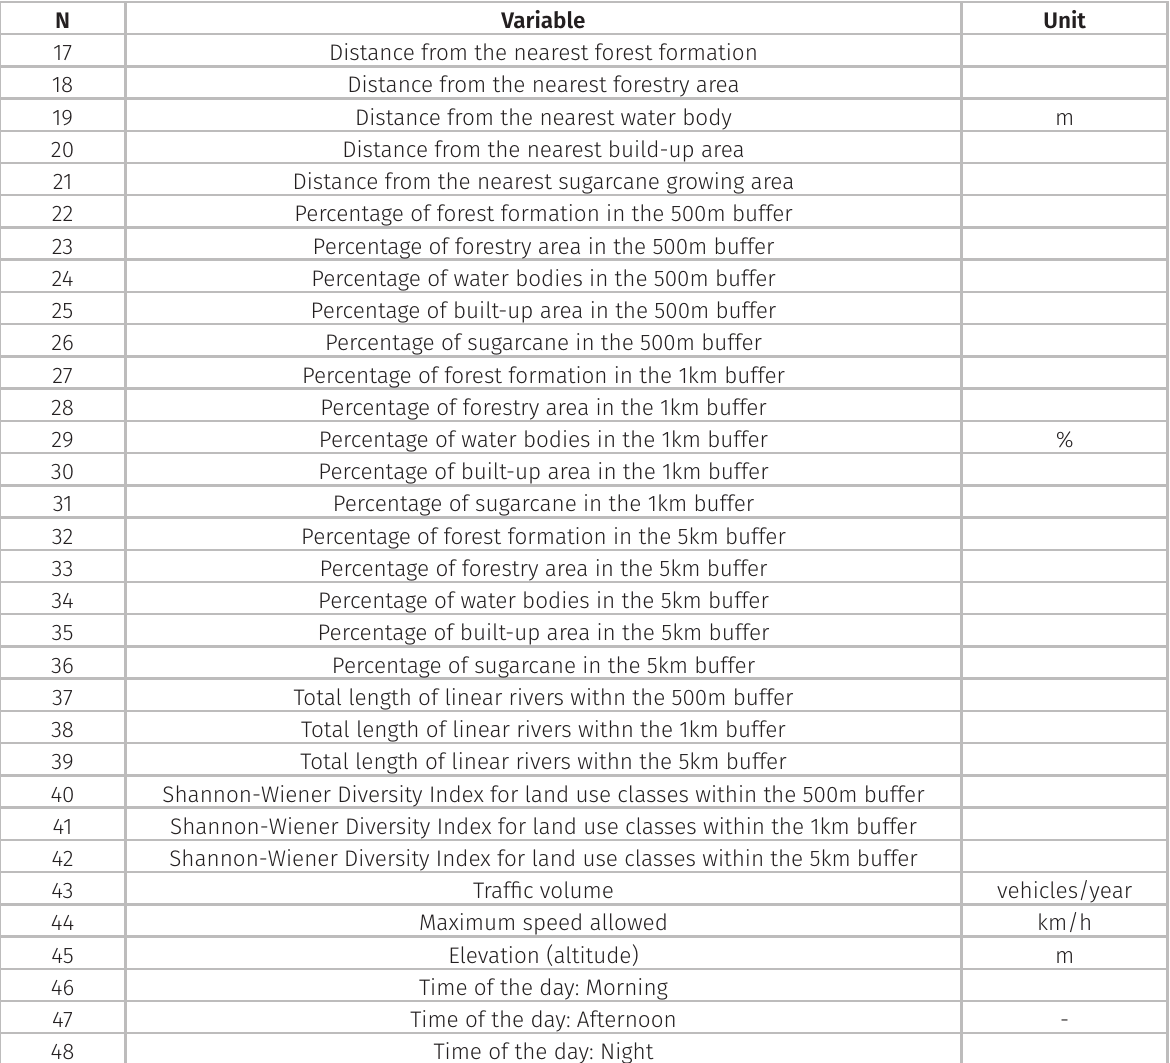
Table III. Land use types and road characteristics (Variables) considered in the